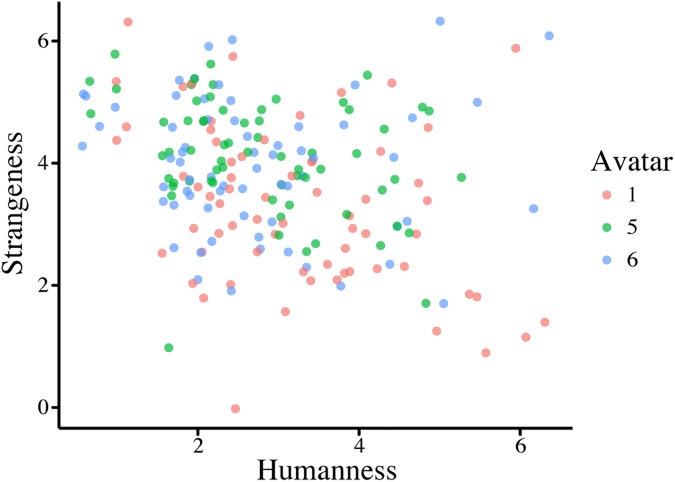
Individual ratings per Avatar.Shows that even though we used a universal manipulation, individual ratings of the avatars differ dramatically. Therefore analysis will not be done on an avatar-by-avatar basis, but as a function of each participant’s individual ratings.